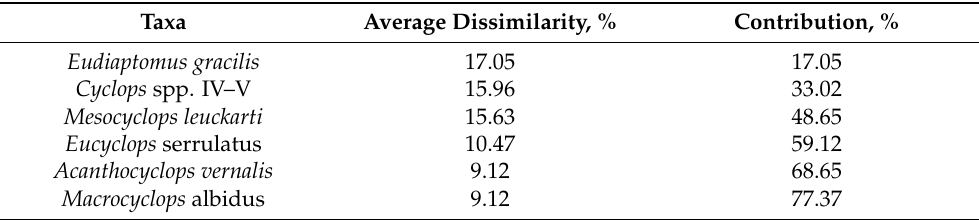
Table 3. SIMPER: List of taxa that contributed the most to the dissimilarity within groups delineated with cluster analysis in Lake Kulonga in March 2016.